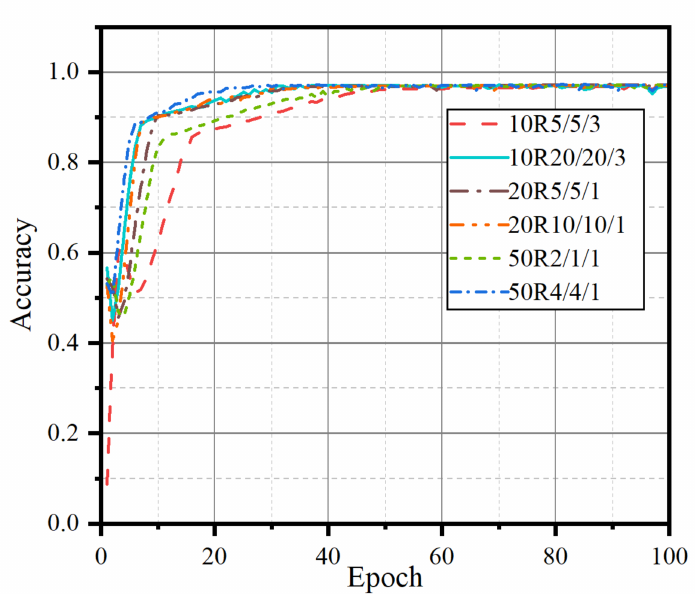
Figure 7. Comparison results of different structures.